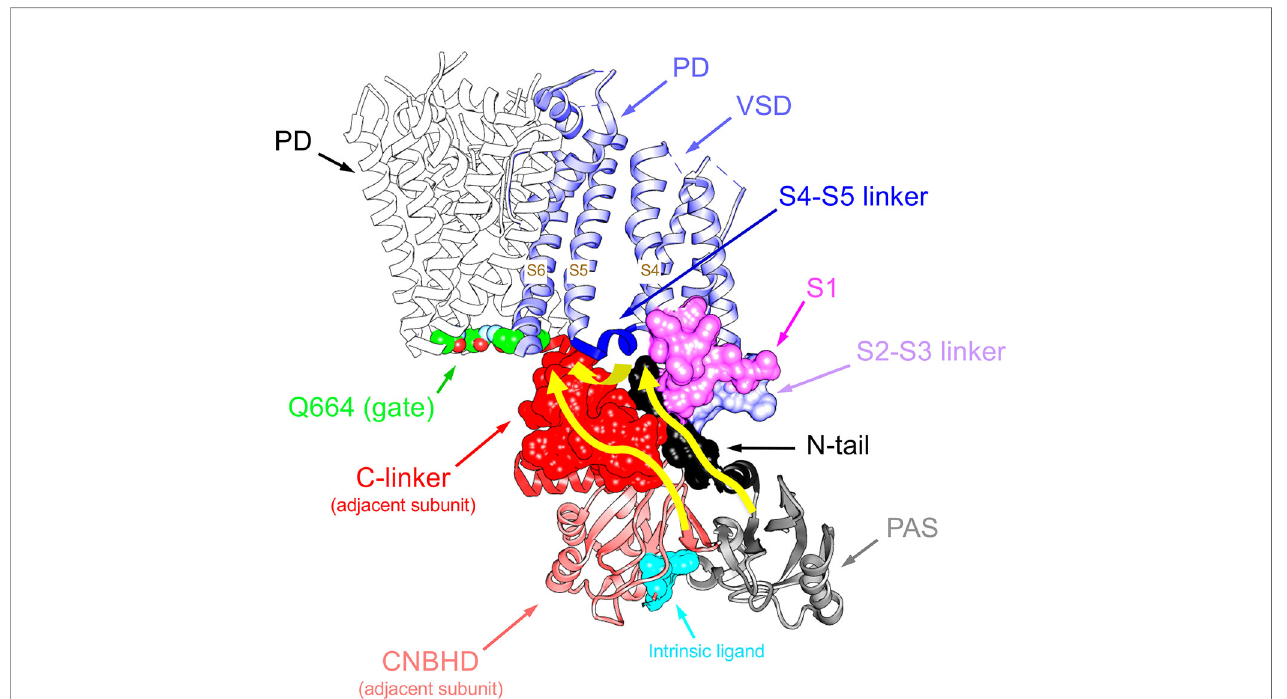
FIGURE 5 | Pathways linking cytoplasmic domains and their possible structural reorganizations to VSD-PD coupling and functional operation of the erg1 (Kv11.1/ hERG) channel gate. For clarity, a single voltage sensor domain (VSD) is shown attached to the tetramer of the pore domain (PD). The four Q664 residues that mark the place of the cytoplasmic gate at the S6 helix bundle are highlighted. Atoms corresponding to the amino terminal N-tail (black), the S2-S3 linker (blue) and the S1 C-terminus of the same subunit (magenta), and the C-linker of the adjacent subunit (red), are shown in space- fi lling mode. The positions of the PAS domain (grey) and the S4 – S5 linker (dark blue), as well as the cyclic nucleotide-binding homology domain (CNBHD), domain of the adjacent subunit (pink), are also depicted. Atoms corresponding to the intrinsic ligand that binds to the cyclic nucleotide binding site of the CNBHD in the P er- A rnt- S im (PAS) – CNBHD interface between two adjacent subunits are presented as cyan spheres at the bottom. Yellow arrows highlight pathways for: (i) direct propagation of CNBHD conformational reorganizations to the pore gate via the C-linker, and (ii) allosteric coupling of the CNBHD to the PAS domain of the neighbouring subunit, and subsequent interplay of the PAS/eag domain with the lower portion of the VSD and the gate via the N-tail and the S4 – S5